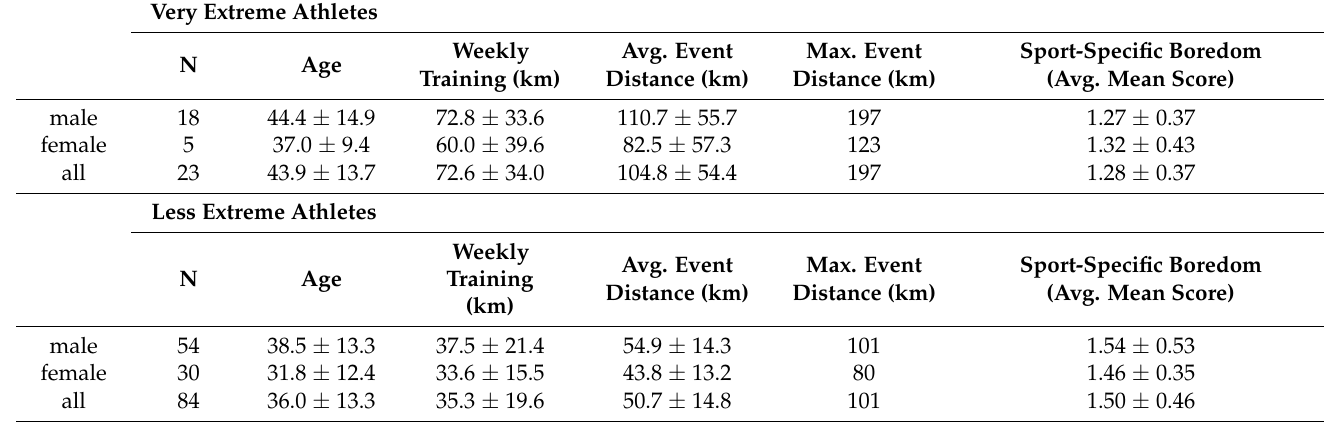
Table 1. Participation, age, and training, as well as event performance